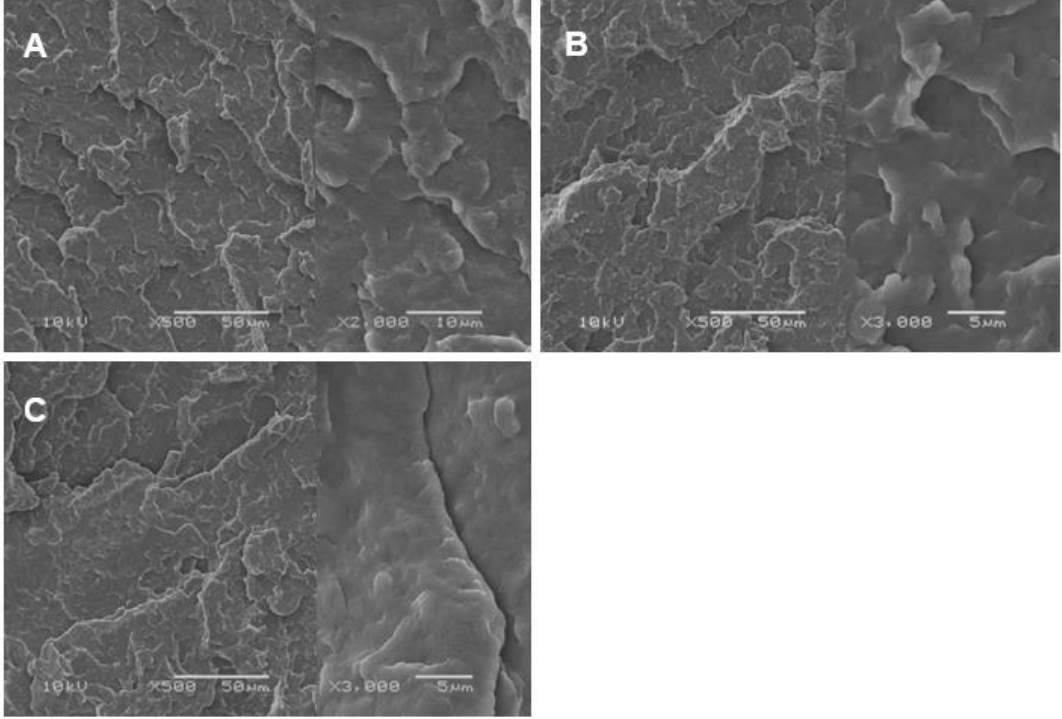
Figure 1. Scanning electron microscopy (SEM) micrographs of fractured surface of neat PLA ( A ) and Figure 1. SEM micrographs of fractured surface of neat PLA ( A ) and PLA/TEC systems prepared by PLA / TEC systems prepared by the modification in the solid ( B ) and molten ( C ) the modification in the solid ( B ) and molten ( C ) state.